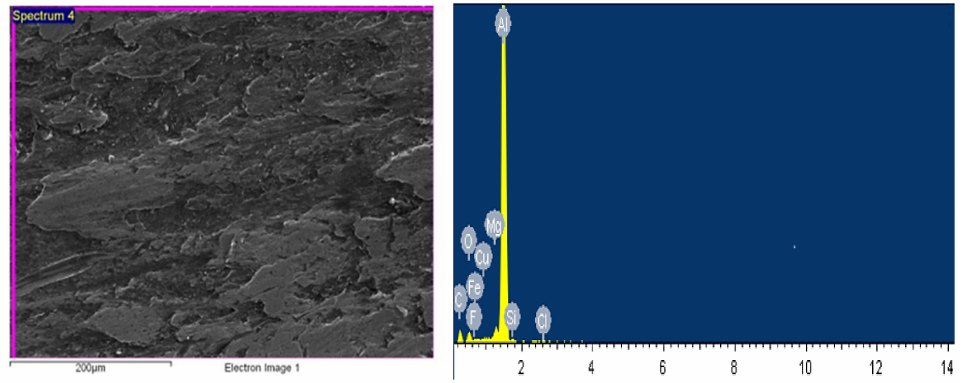
Figure 5. SEM and EDS images of Al-Mg-0.6Si-0.35Fe/15%RHA/5%Cu hybrid composite workpiece before